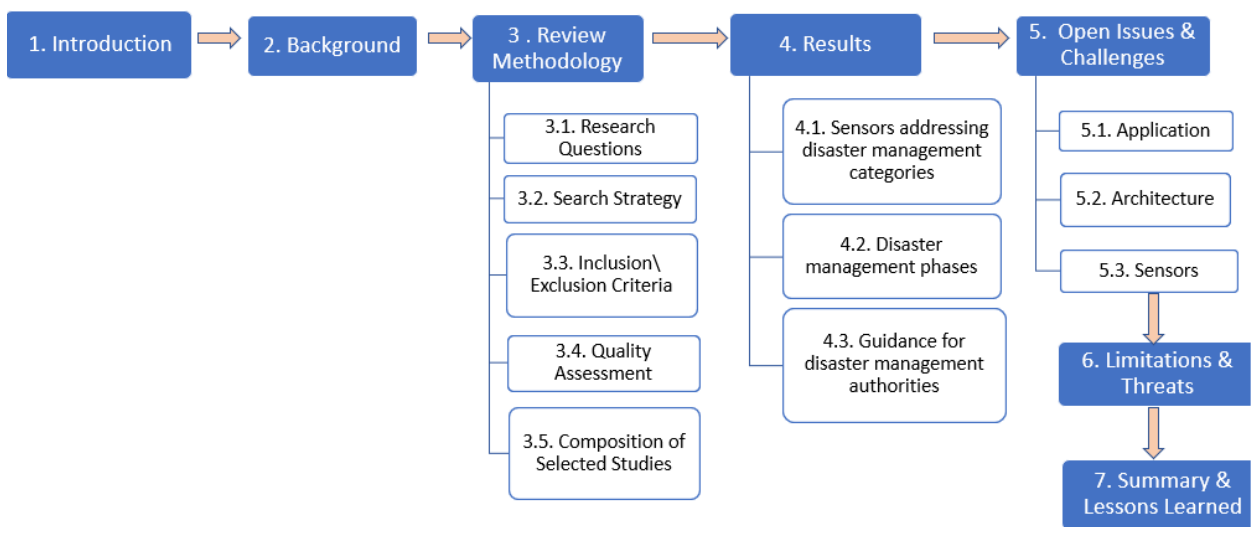
Figure 2. Structure of the